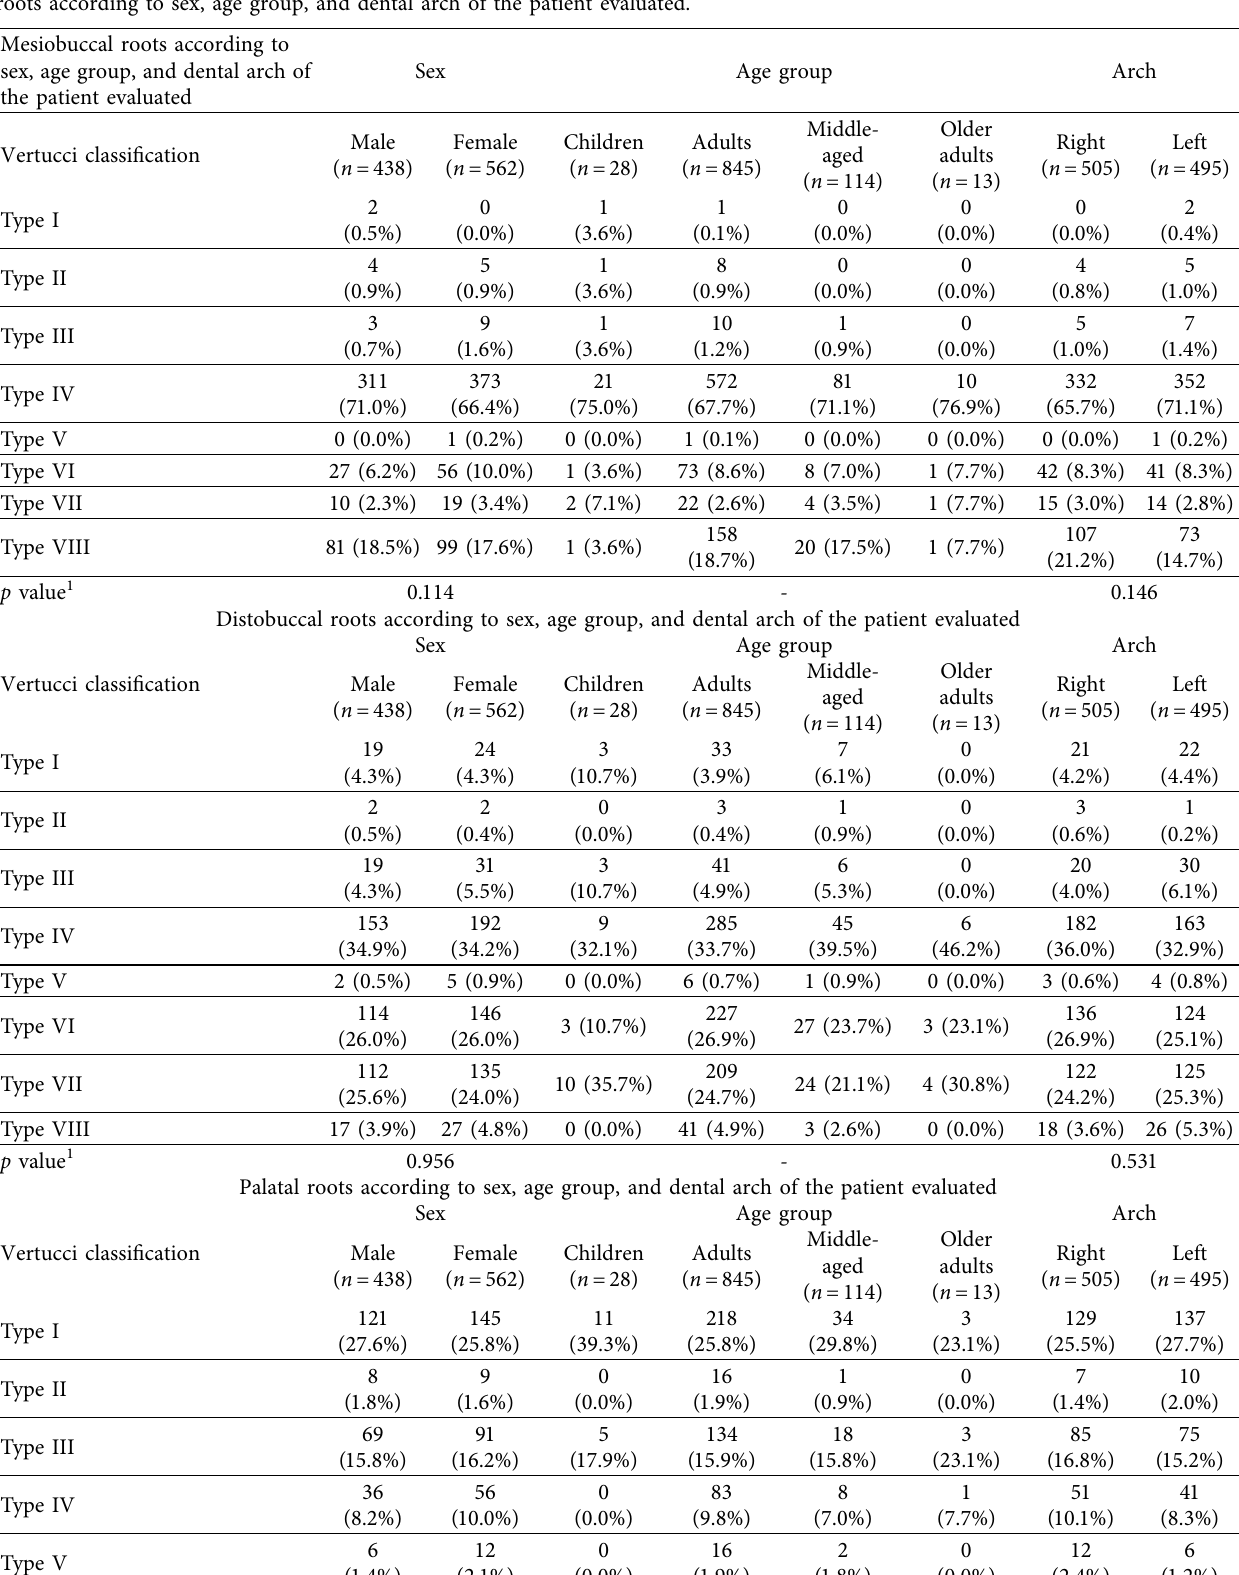
Table 5: Distribution of the different morphological types proposed by Vertucci [15] for mesiobuccal roots, distobuccal roots, and palatal roots according to sex, age group, and dental arch of the patient